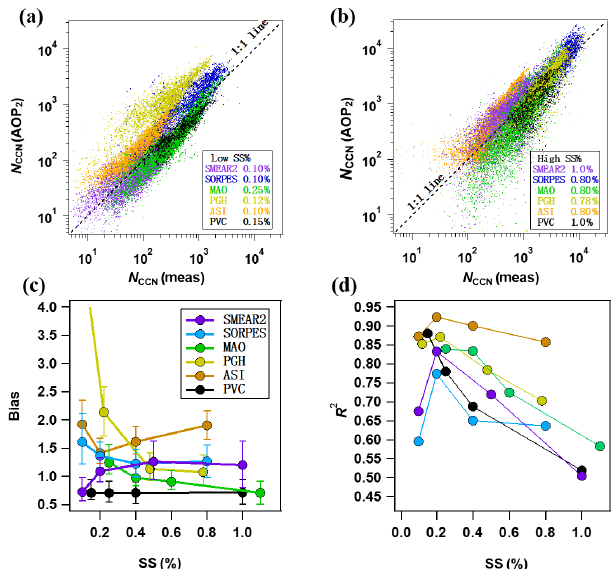
Figure 8. Statistics of N CCN (AOP 2 ) from parameterization in Eq. (10). N CCN (AOP 2 ) vs. N CCN (meas) at different sites at relatively (a) low and (b) high supersaturations, (c) bias = N CCN (AOP 2 ) /N CCN (meas) at different sites and supersatura- tions, and (d) R 2 of the linear regression of N CCN (AOP 2 ) vs. N CCN (meas) at different sites and supersaturations.